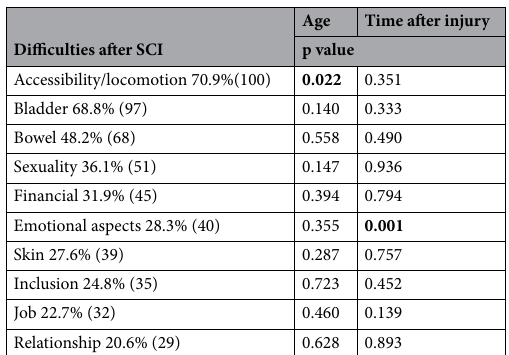
Table 2. Presentation of test results between “difficulties after SCI” and the variables “age” and “time of spinal cord injury”, Brazil, 2018. *Teste Mann–Whitney. Significant values are in [bold].